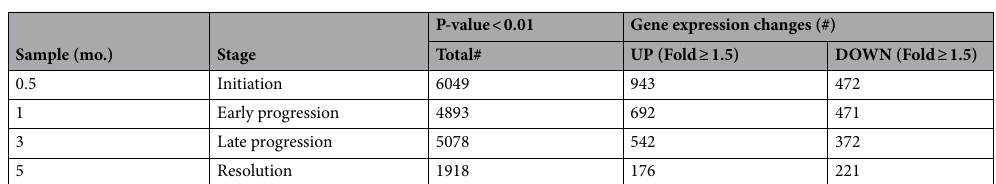
Table 1. Distribution of altered gene expression in gingival tissues during ligature-induced periodontitis and at disease resolution compared to baseline healthy tissues.